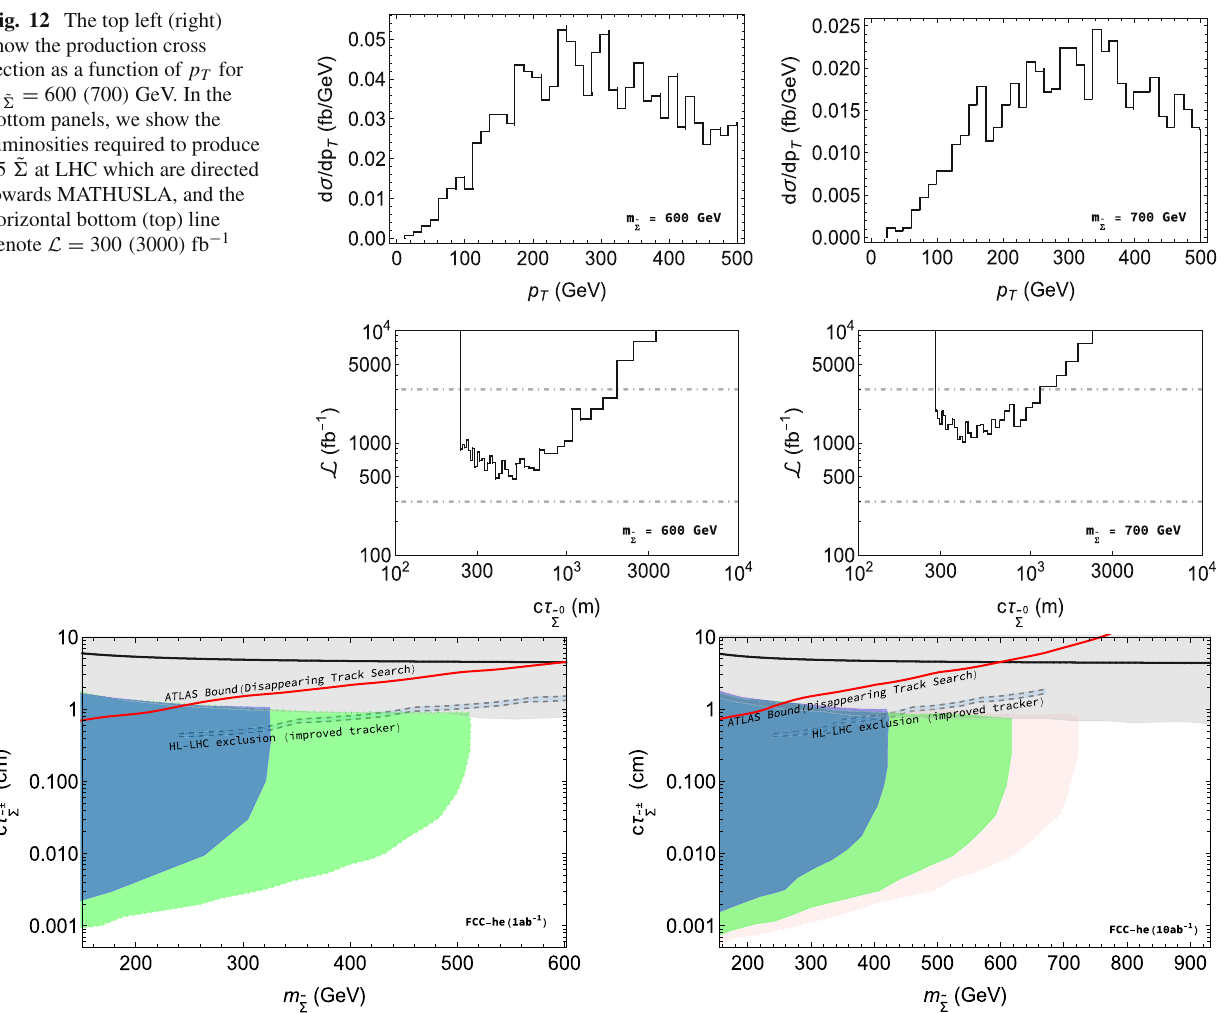
Fig. 13 The plots show the prospects of observing displaced vertex from (cid:2) ± decay at FCC-he. The blue and green shaded regions indicate the parameter space where 100 (10) events with at least one long-lived (cid:2) ± . The light-red shaded region indicate 2- σ exclusion sensitivity if the backgrounds are harder to reject. The grey shaded region are still